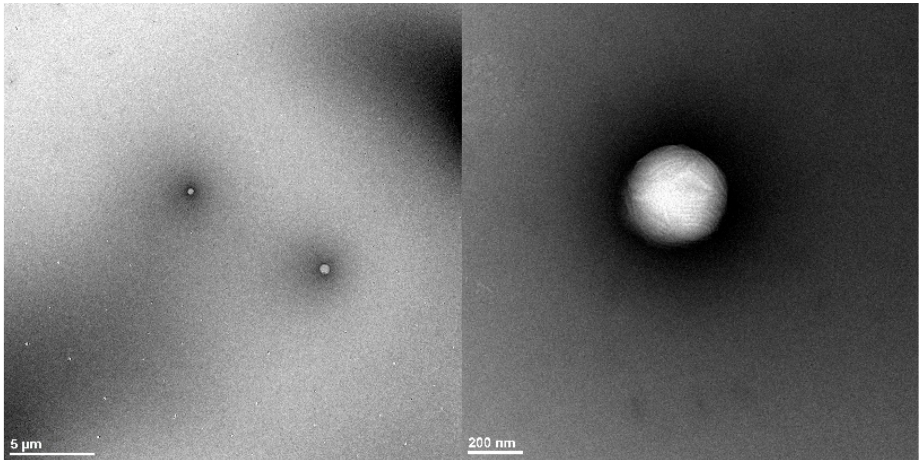
Figure 5. TEM images of the optimized FLZ nanoparticle formulation.